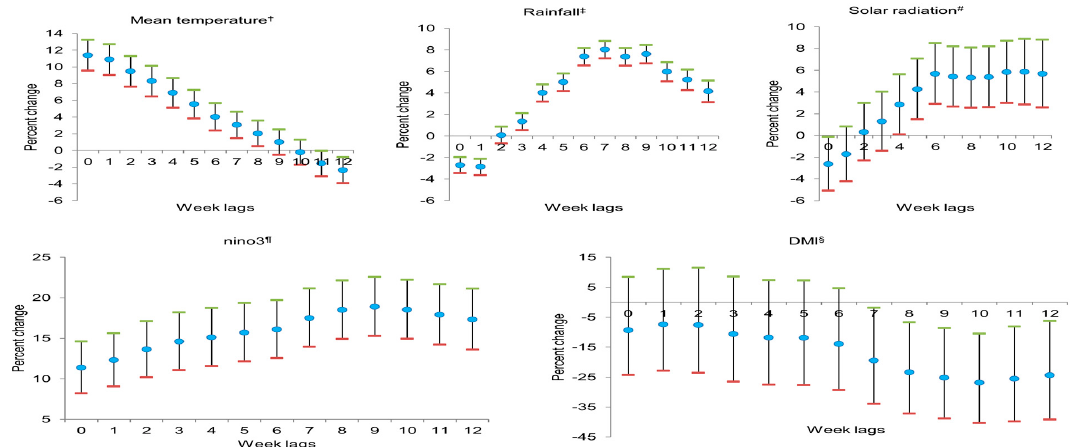
Figure 4. Quasi-Poisson regression model showing associations between climate variables and the weekly number of aseptic meningitis cases from 2002 to 2012 in six metropolitan provinces of Korea. † Weekly average of daily mean temperature (°C); ‡ weekly average of daily rainfall (mm); # weekly average of daily solar radiation (mJ/m 2 ); ¶ weekly average of sea surface temperature in Nino3 region, § weekly average of Dipole Mode Index.